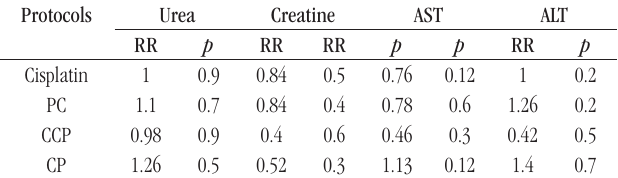
table 5 – Association and RR of using the various protocols × biochemical changes, Caruaru, Pernambuco, 2018